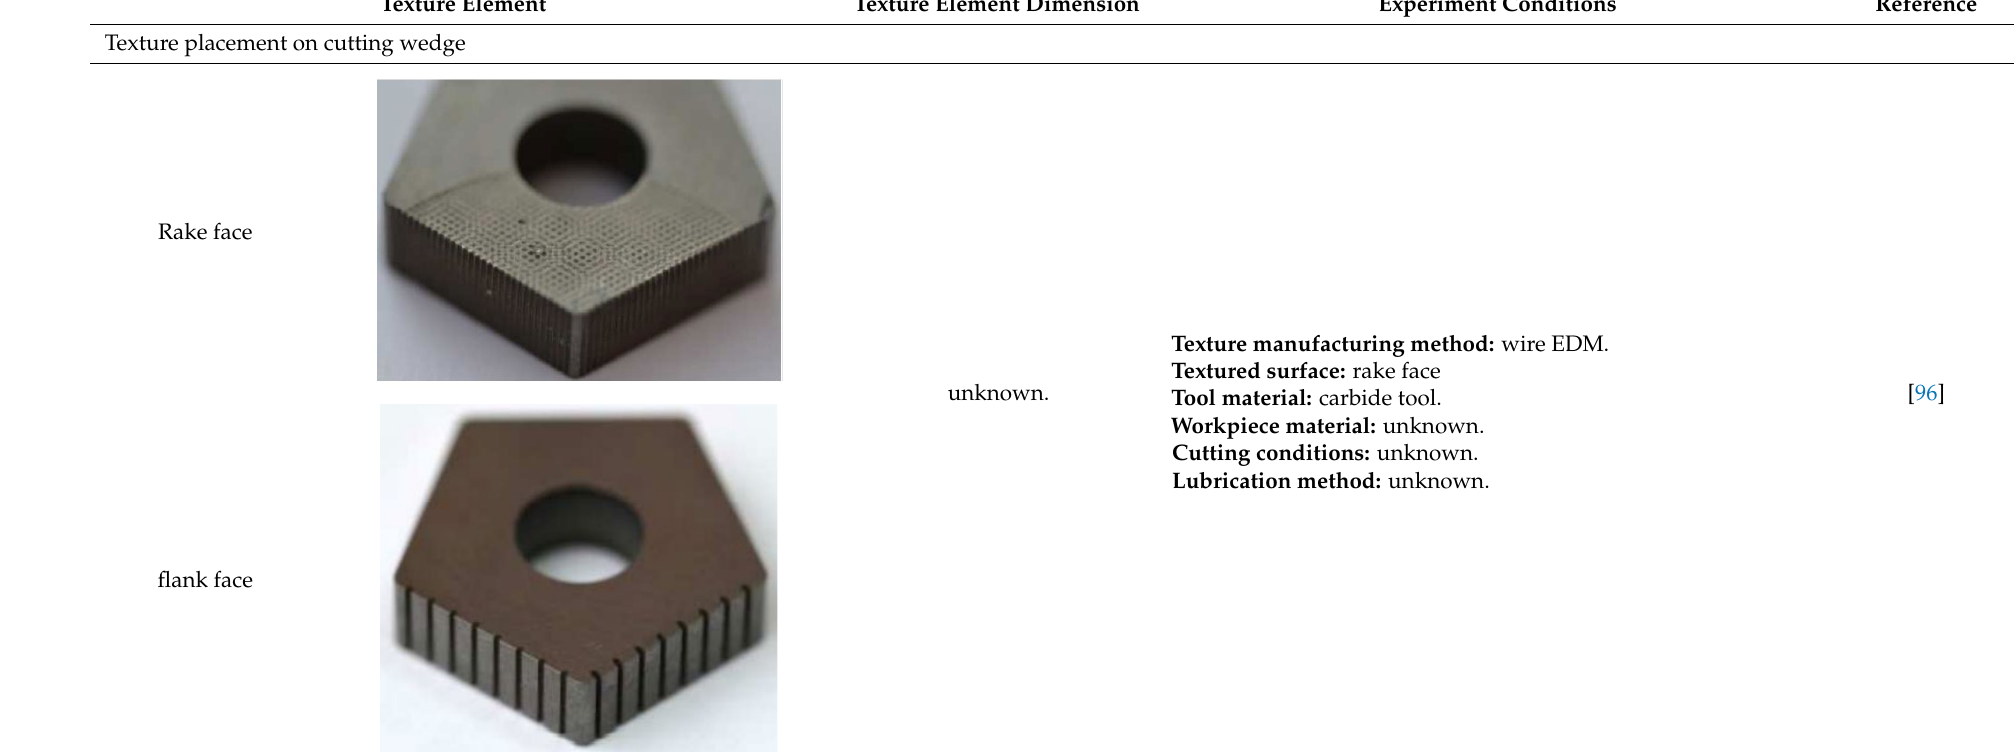
Table A3. Cont. Texture